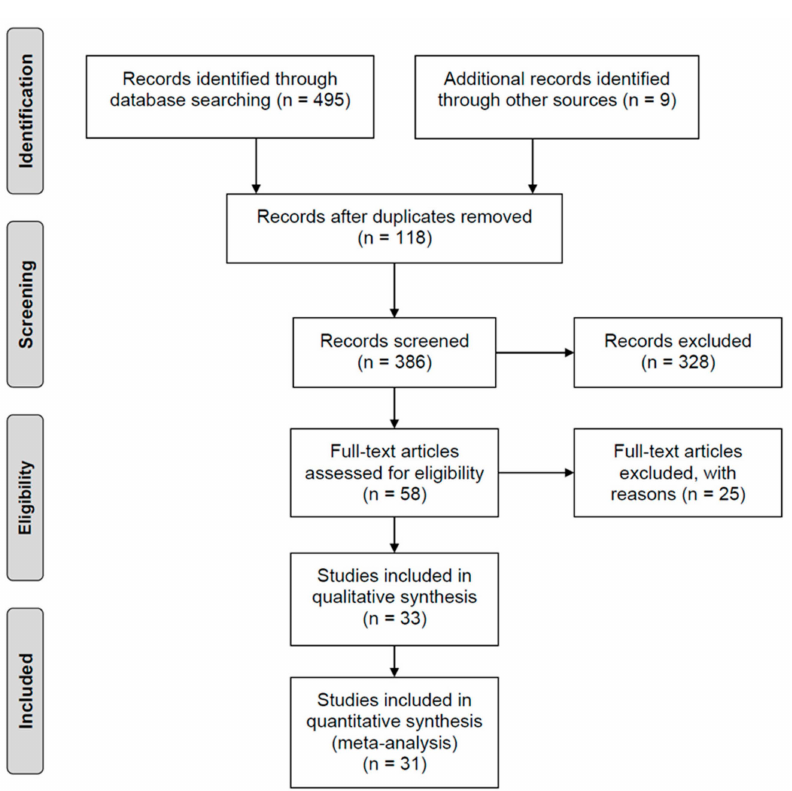
Figure 1. Preferred Reporting Items for Systematic Reviews and Meta-Analyses (PRISMA) flow